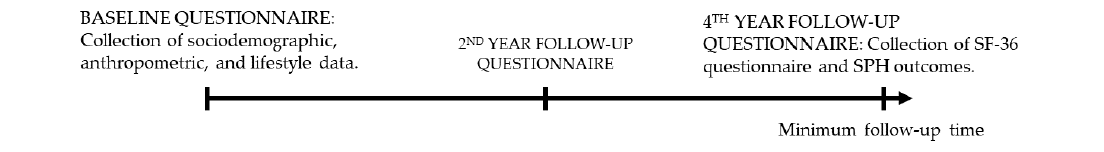
Figure 1. Data origin for the present analysis.